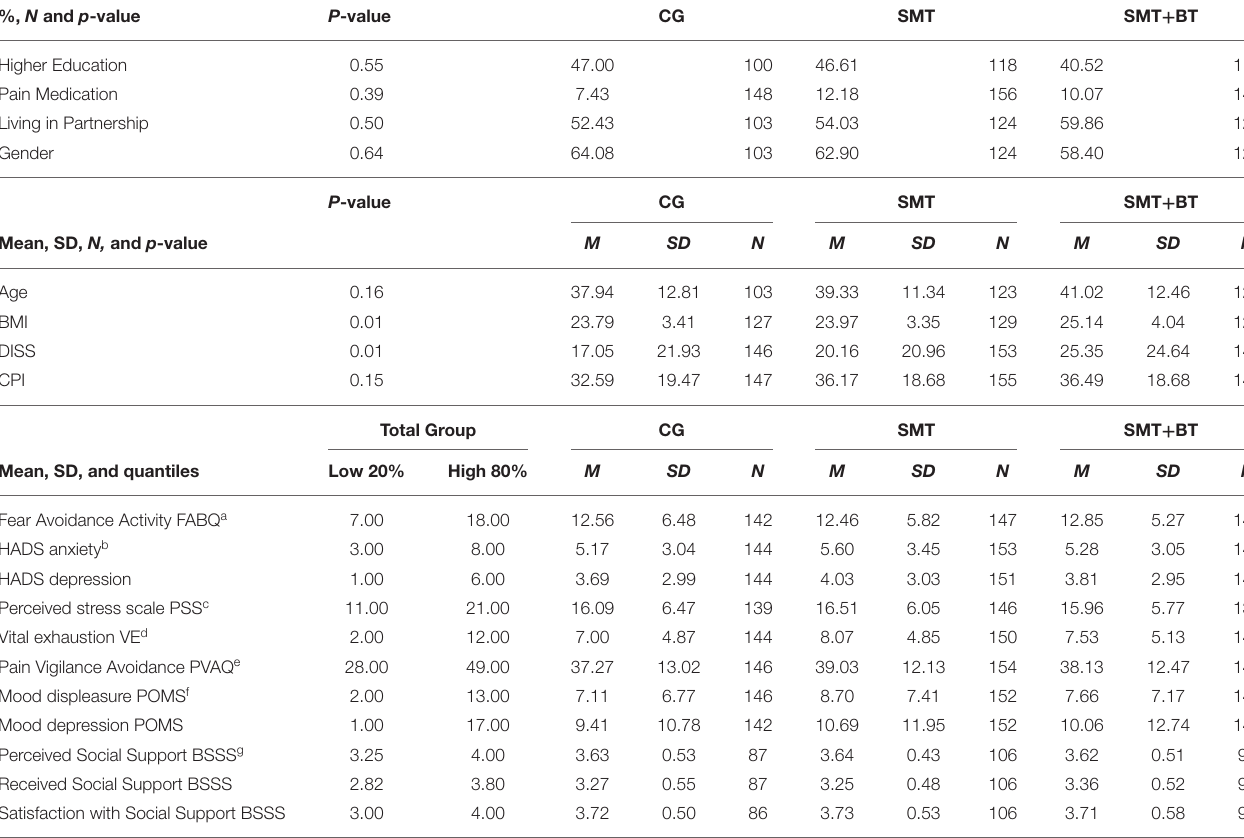
TABLE 1 | Baseline sample and descriptive characteristics ( M, SD ) of psychosocial factors (separated for each scale/group). %, N and p -value P -value Higher Education